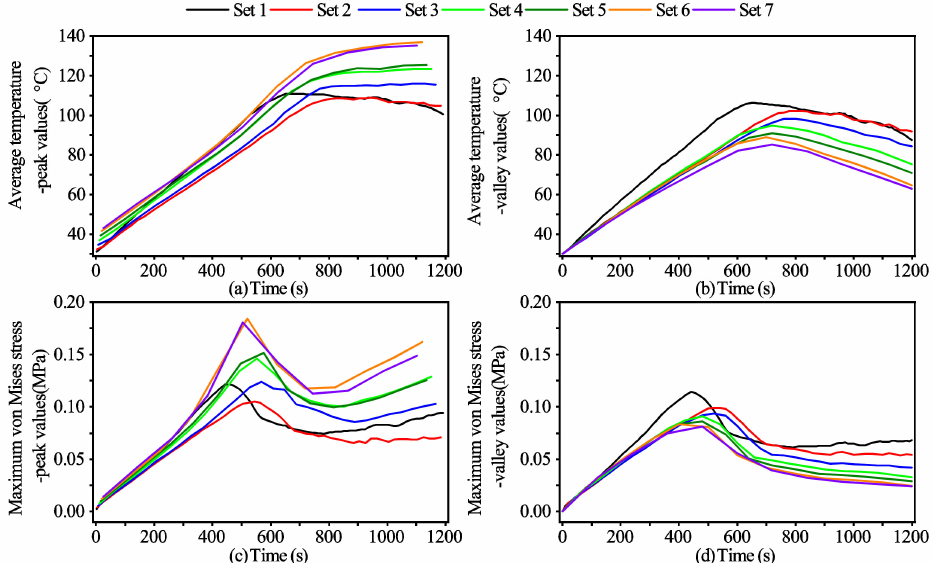
Figure 13. The temperatures and stresses of different settings. ( a ) The peak values of the average temperature of different settings. ( b ) The valley values of the average temperature of different settings. ( c ) The peak values of the maximum von Mises stress of different settings. ( d ) The valley values of the maximum von Mises stress of different